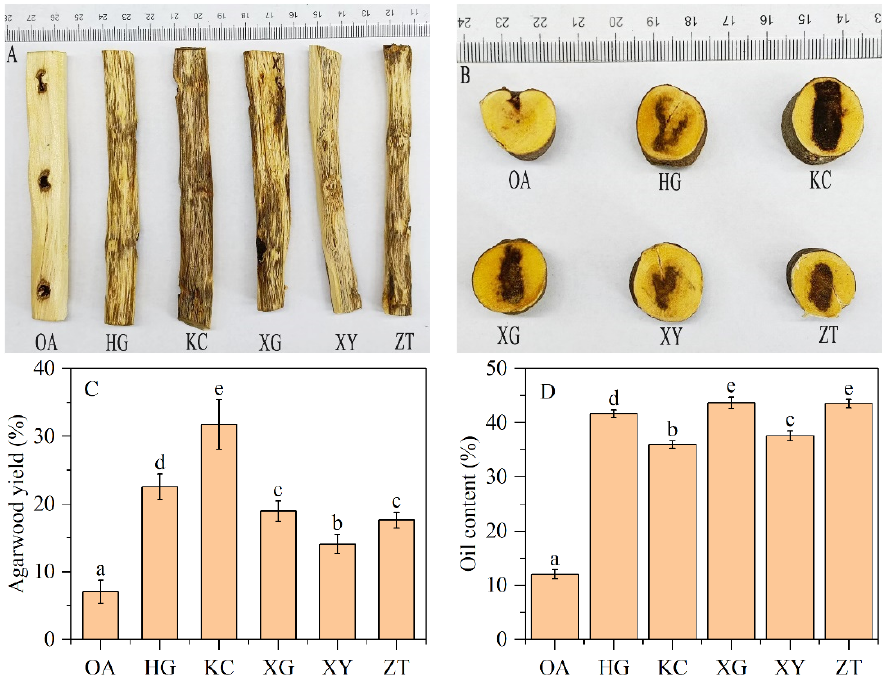
Figure 1. Agarwood formation, and agarwood yield and essential oil content of OA and Qi-Nan. Different letters denote significant ( p < 0.05) differences among OA and five Qi-Nan clones in a one-way ANOVA, and the bar represents a standard deviation ( n = 5). “OA” ordinary agarwood, “HG, KC, XG, XY, ZT” represent five Qi-Nan clones, The basic situation of the agarwood formation on the radial section ( A ), The basic situation of agarwood formation on the cross-section ( B ), Agarwood yield ( C ), Oil content ( D ).